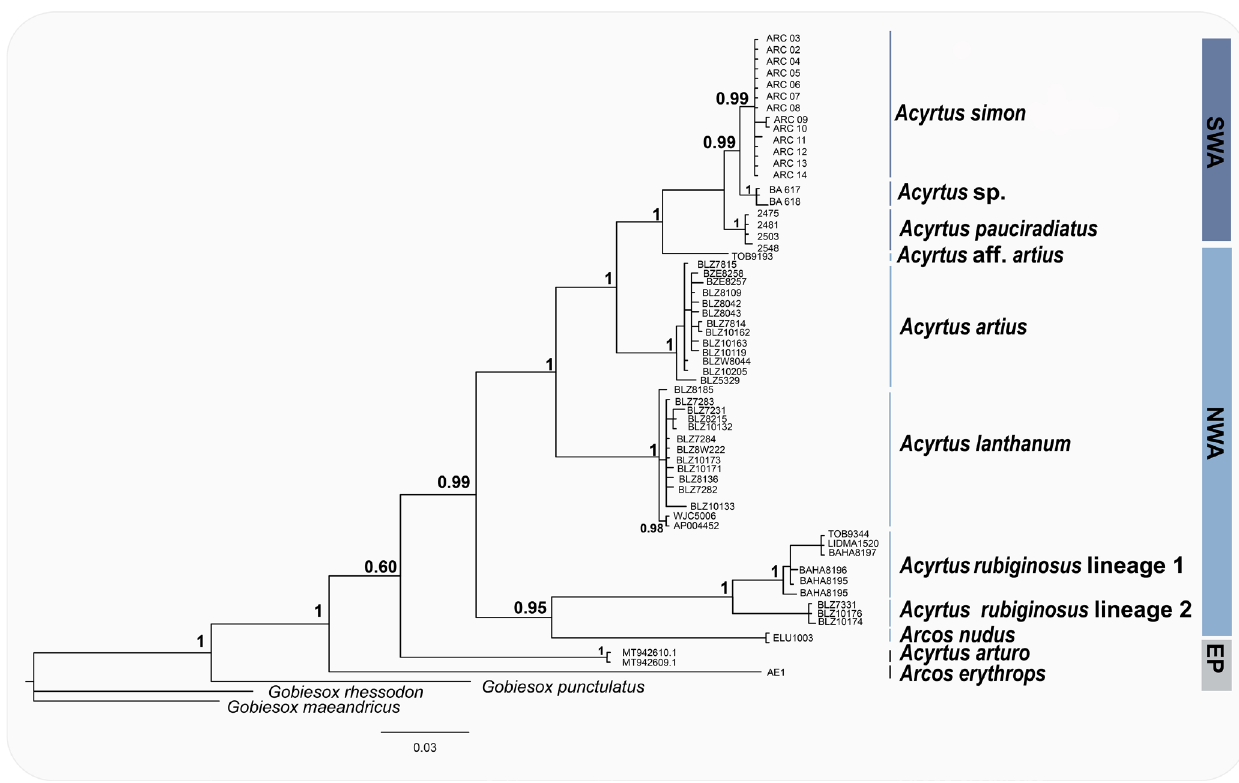
FIGURE 3 | Bayesian phylogeny of Acyrtus based on the COI gene. Bayesian posterior probability values are shown and the biogeographic province of lineages presented in the right. SWA: southwestern Atlantic; NWA: northwestern Atlantic; EP: eastern